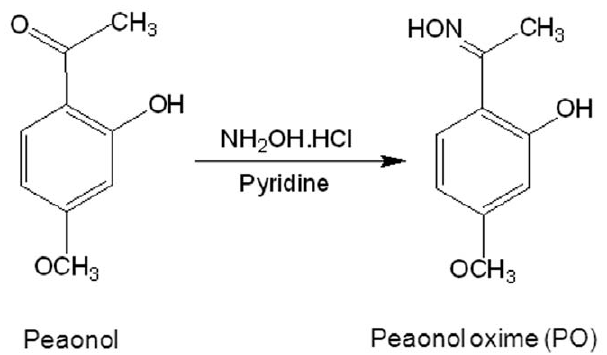
Figure 1. Chemical structure of paeonol oxime. Paeonol oxime (PO) (1-[2-hydroxy-4-methoxy phenyl] ethanone oxime) was synthe- sized from paeonol.